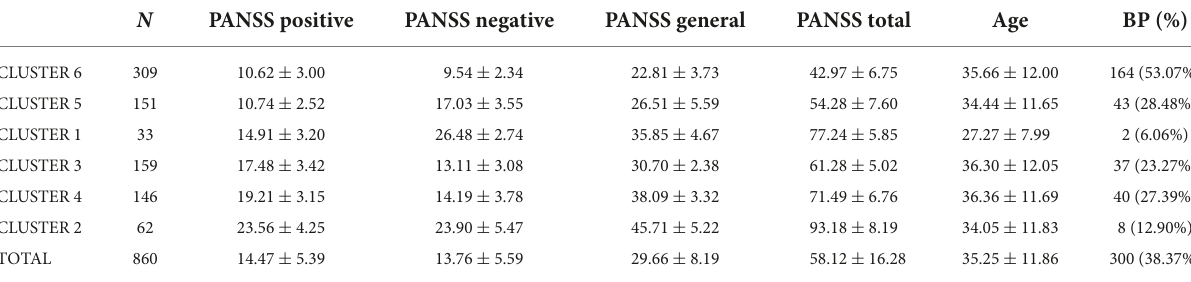
TABLE 4 PANSS subscale spread across